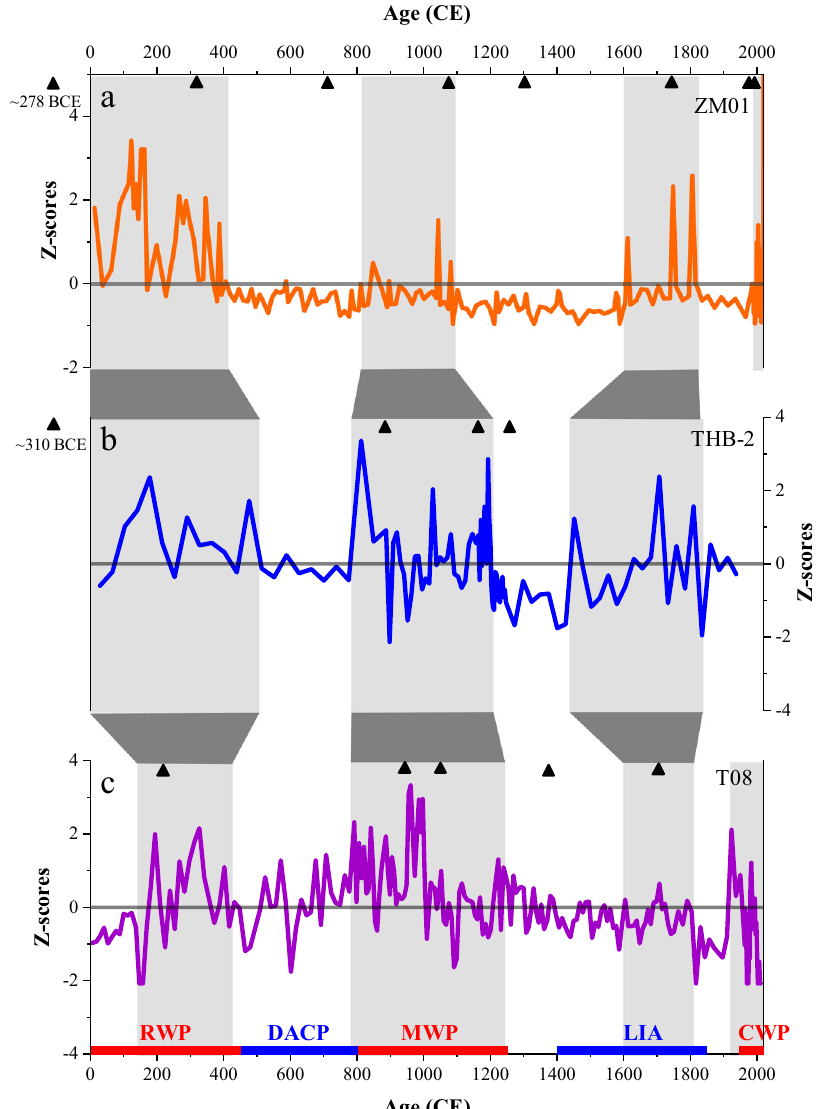
Fig. 4 Tropical cyclone records from the ZFMB, offshore eastern China. a – c Sand content from cores ZM01, THB-2 38 , and T08 25 . All time series are normalized to standard Z -scores. Standard Z -scores are calculated according to Z = ( X − V )/SD; here X is the original value, V is the averaged value of the time series, and SD is the standard deviation of the time series. In all records, black triangles mark the radiocarbon